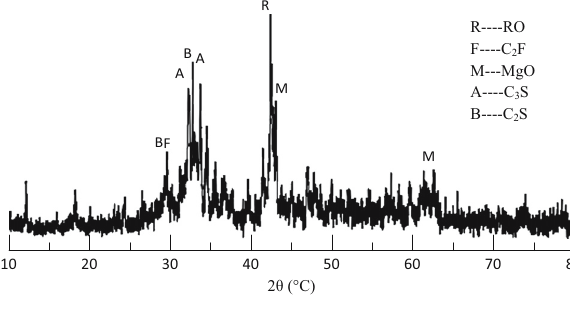
Figure 2: XRD pattern of SSA.